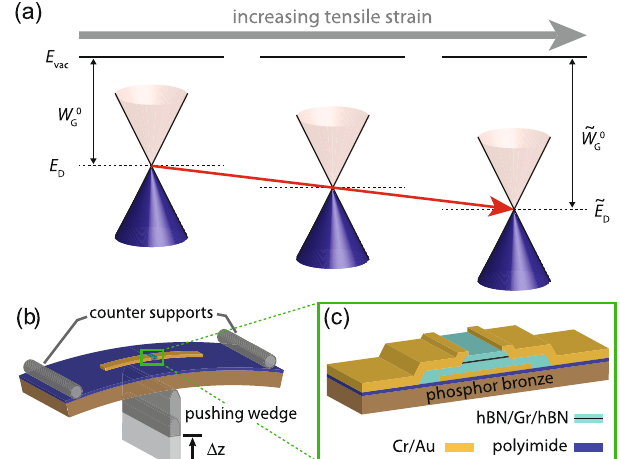
Fig. 1 Schematic representation of inducing scalar potential by strain. a Illustration of the strain induced shift of the Dirac point. The vacuum level is labeled with E vac , and the Dirac point and the work function of unstrained (strained) graphene with E D ( e E ) and W 0 ( e W 0 ), respectively. b Schematics D G G of the three-point bending setup and c the encapsulated graphene